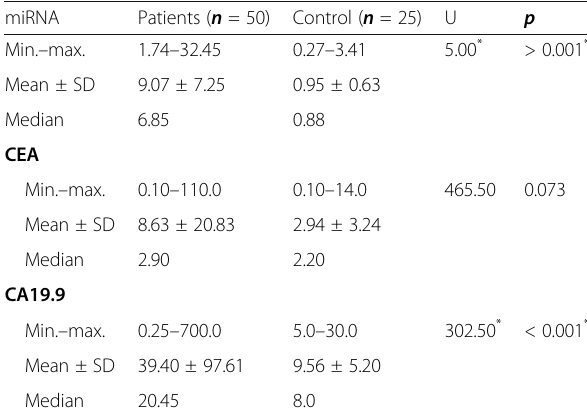
Table 3 Levels of miR-17-3p, CEA, and CA19.9 in studied population (patients and control)